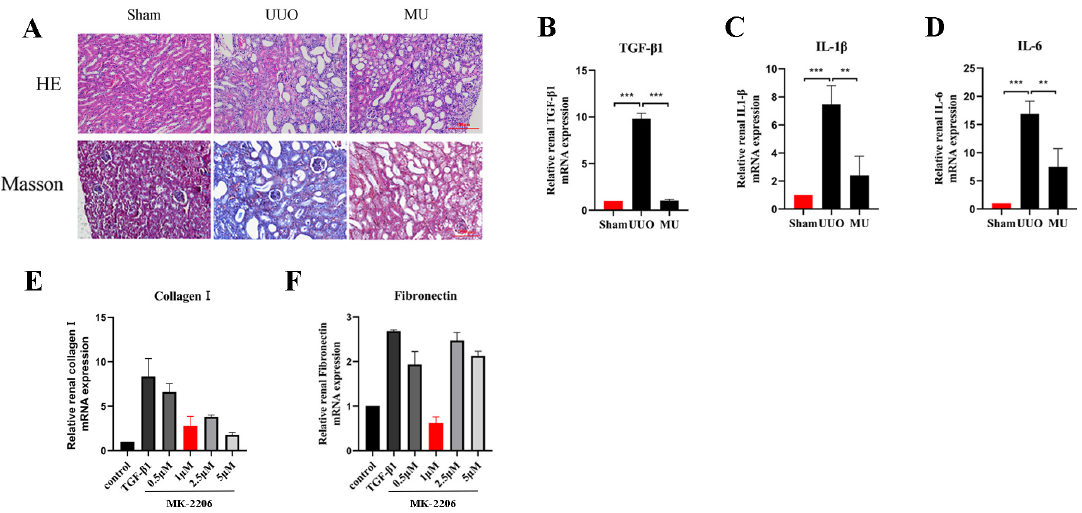
Figure 3. MK-2206 attenuated renal injury and reduced inflammatory factors. ( A ) H&E staining and Masson staining were performed to examine the extent of renal injury and collagen fiber deposition in each group of mice, respectively (scale bar: 100 µ m). ( B – D ) mRNA levels of inflammatory factors TGF- β 1, IL-1 β , and IL-6 were detected by real-time PCR in each group of mice. ( E , F ) mRNA levels of Collagen I and Fibronectin in HK-2 cells treated by different concentrations of MK-2206 were detected by real-time PCR. The levels of mRNA expression were normalized with GADPH. ** p < 0.01, *** p < 0.001. MU: UUO + MK-2206.